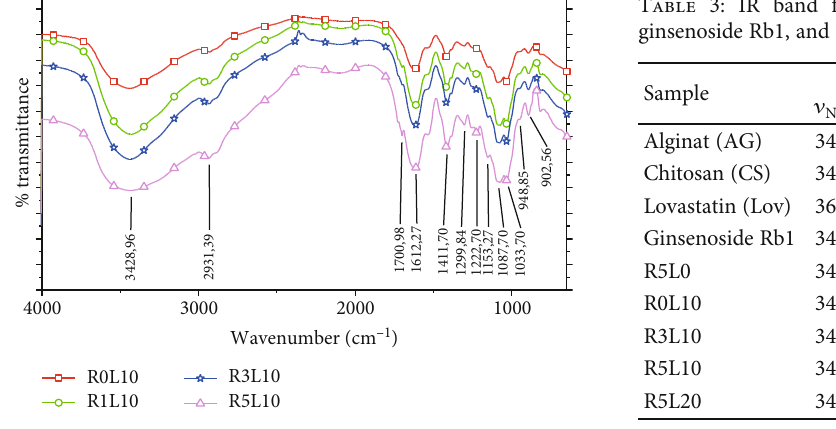
Figure 2: FTIR spectra of NPB-RxL10.